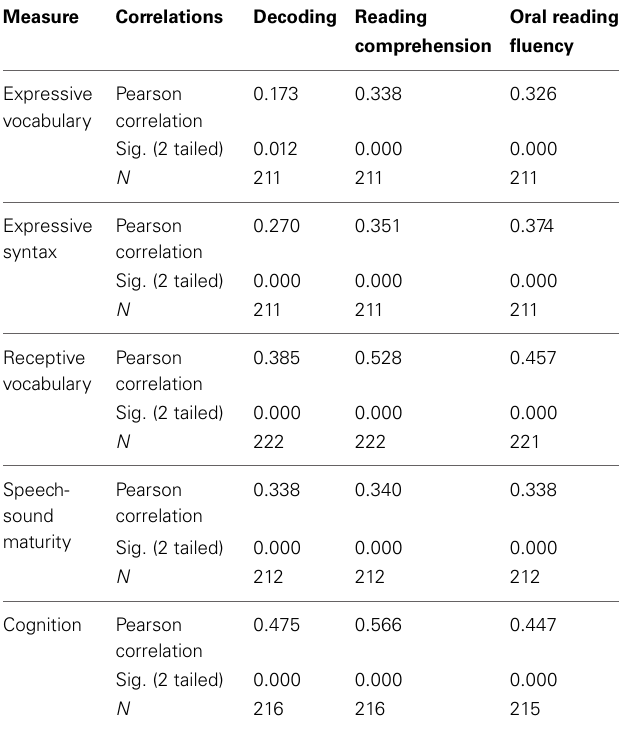
Table 4 | Pearson moment correlations of preschool measures with school-aged reading measures.